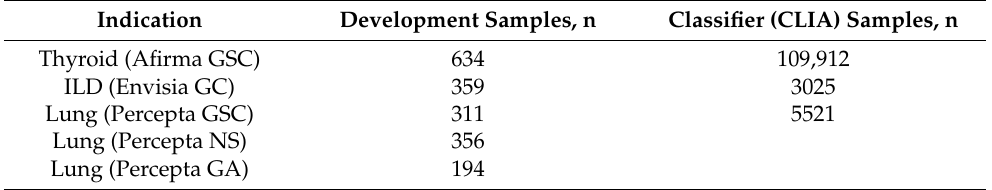
Table 1. Clinical samples